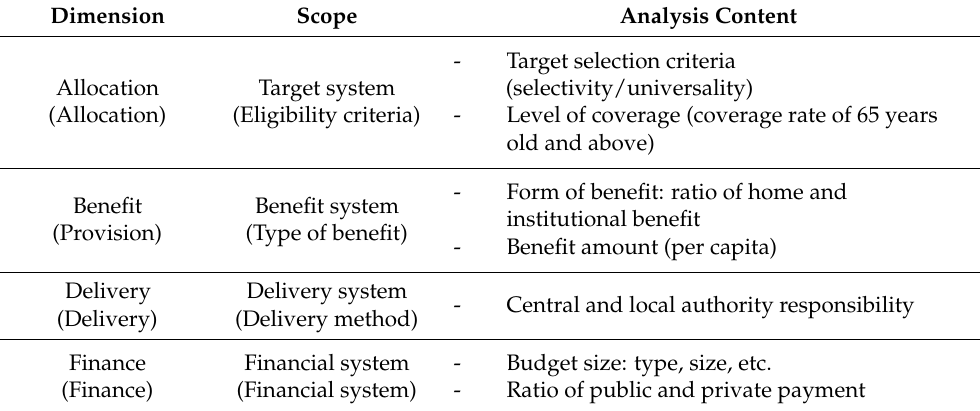
Table 1. Analysis framework of the